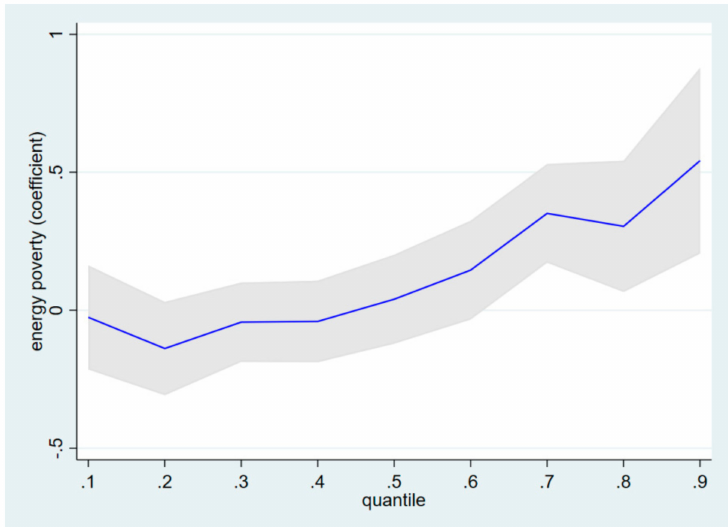
Figure 2. Quantile regression estimates for the impact of energy poverty (EP1) on depression. Notes: The x -axis denotes the 9 conditional quantiles of the CES-D8 depression scores, and the y -axis presents the coefficient estimates of energy poverty measure (EP1). Shaded areas correspond to 95% confidence intervals of quantile